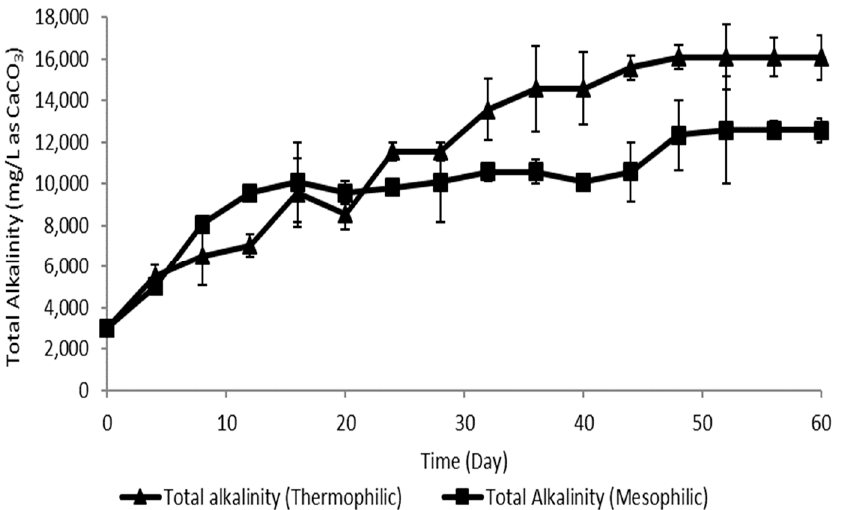
Figure 7. The range of total alkalinity for thermophilic and mesophilic e ffl uents during the Figure 7 . The range of total alkalinity for thermophilic and mesophilic effluents during the acclimatization acclimatization period. Notes: error bars show standard deviation of means (n = period. Notes: error bars show standard deviation of means (n = 3).